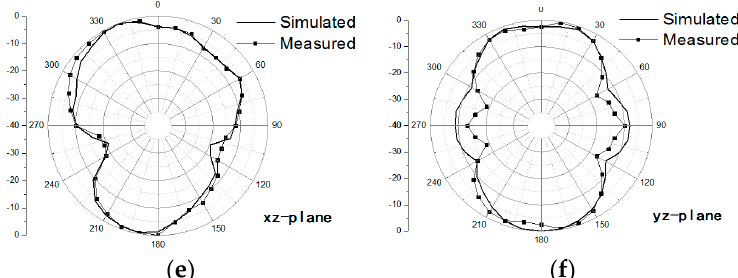
Figure 12. The Simulated and measured gain pattern of the proposed antenna in normalization at 2 GHz ( a , b ), 4 GHz ( c , d ) and 6 GHz ( e , f ).